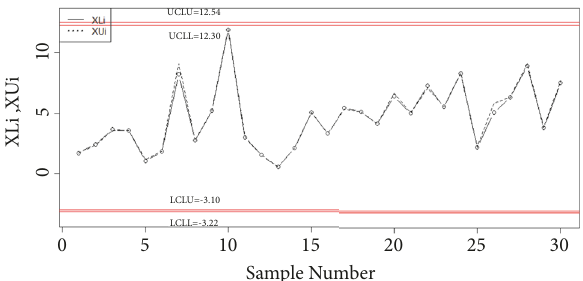
Figure 3: The proposed control chart for the real data.